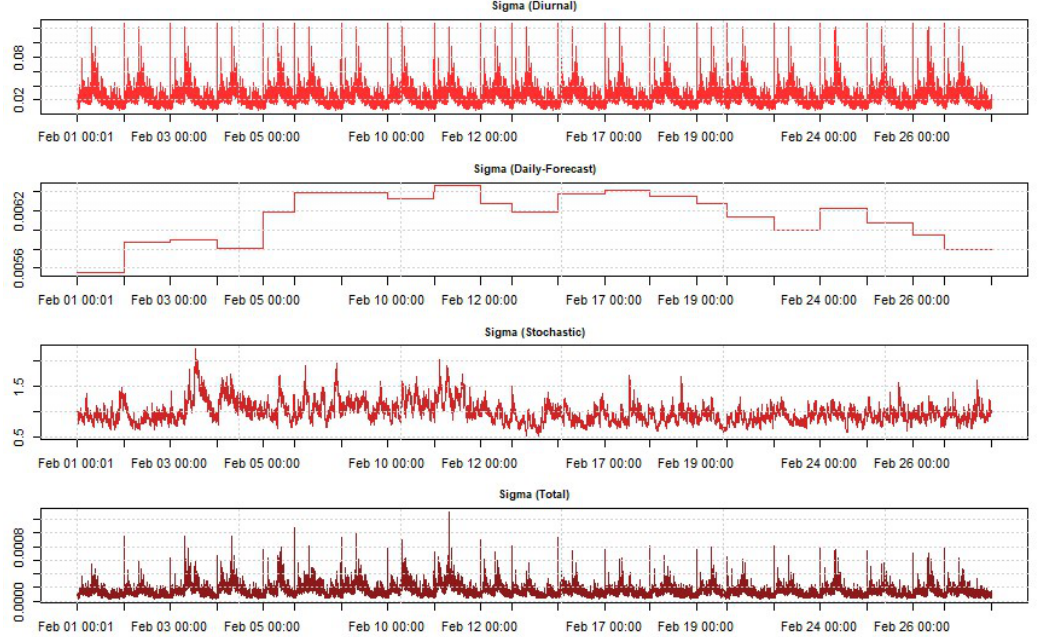
Figure 6. Diurnal component, daily volatility component, intradaily volatility component, and total composite volatility.